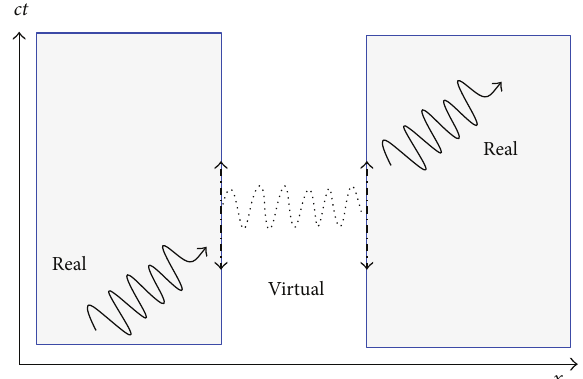
Figure 5: Minkowski diagram of the tunneling of photons through a potential “barrier” of length 𝐿 measured in the laboratory